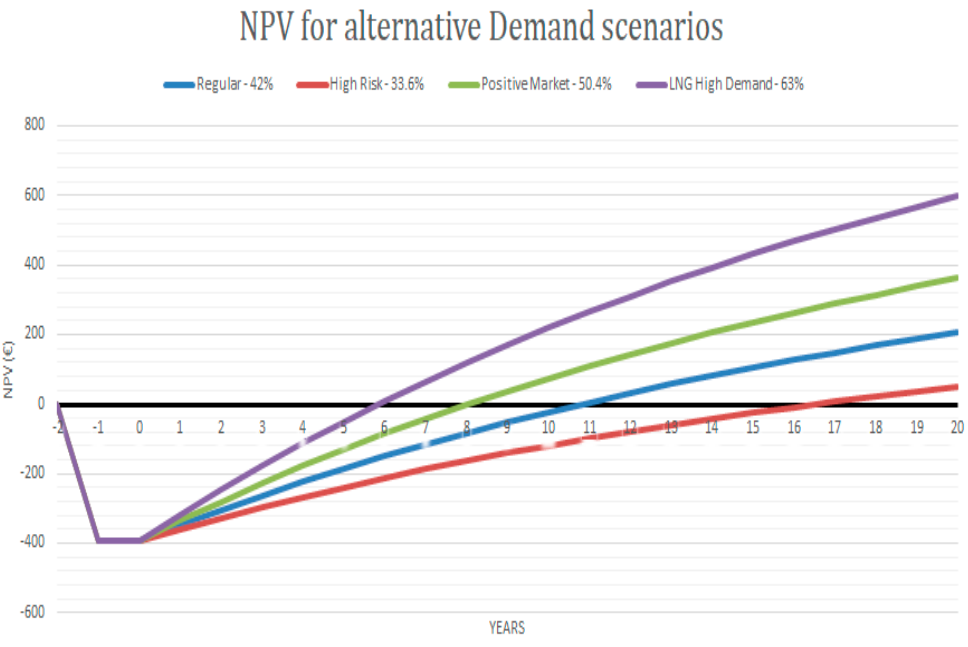
Figure 3. NPV during operation period for alternative usage rate scenarios. (NPV in millions